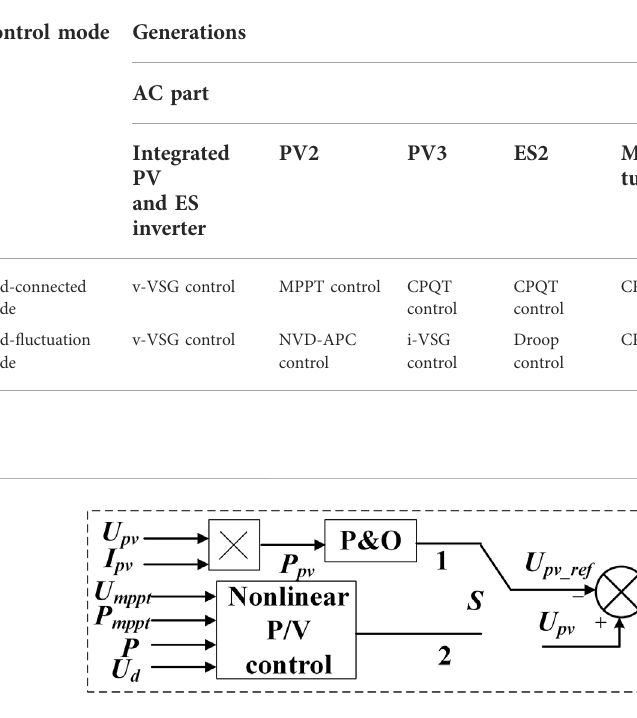
TABLE 1 Control strategies of the DGs in different modes.